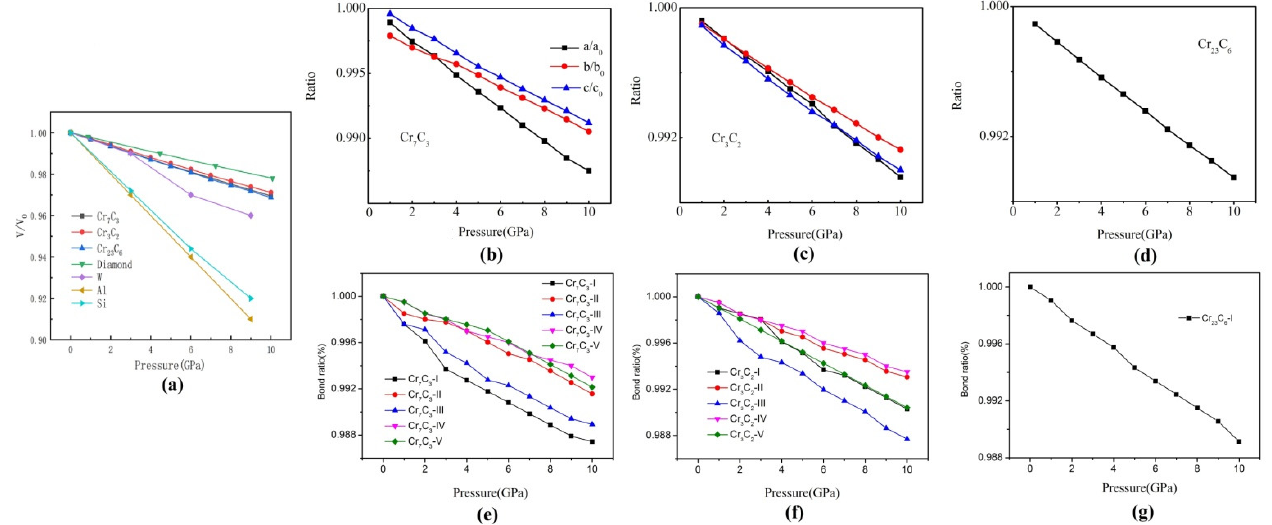
Figure 2. The chemical bonding properties of binary chromium carbides under hydrostatic pressure: ( a ) the unit cell volume rate ( V / V 0 ), ( b ) lattice parameters ratio ( a / a 0 , b / b 0 , c / c 0 ) of Cr 7 C 3 , ( c ) lattice parameters ratio ( a / a 0 , b / b 0 , c / c 0 ) of Cr 3 C 2 , ( d ) lattice parameters ratio ( a / a 0 , b / b 0 , c / c 0 ) of Cr 23 C 6 , ( e ) the chemical bonding properties of Cr 7 C 3 under hydrostatic pressure, ( f ) the chemical bonding properties of Cr 3 C 2 under hydrostatic pressure, ( g ) the chemical bonding properties of Cr 23 C 7 under hydrostatic pressure [23].